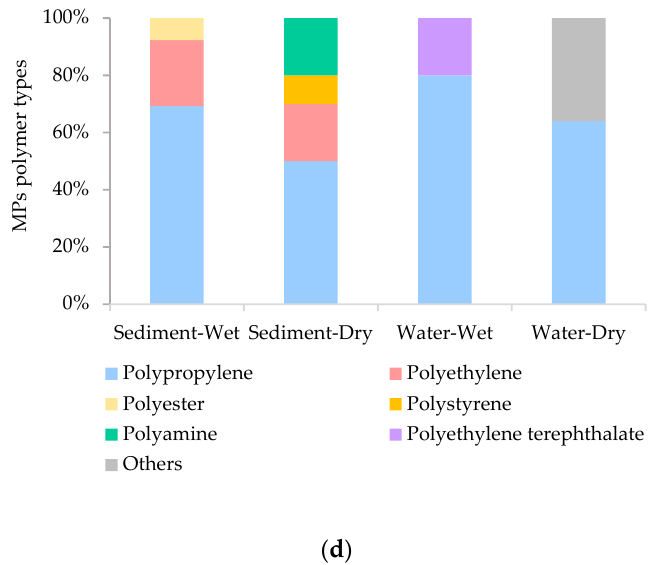
Figure 4. Microplastics’ morphological characteristics: ( a ) color, ( b ) shape, ( c ) size (μm) and ( d ) polymer type.